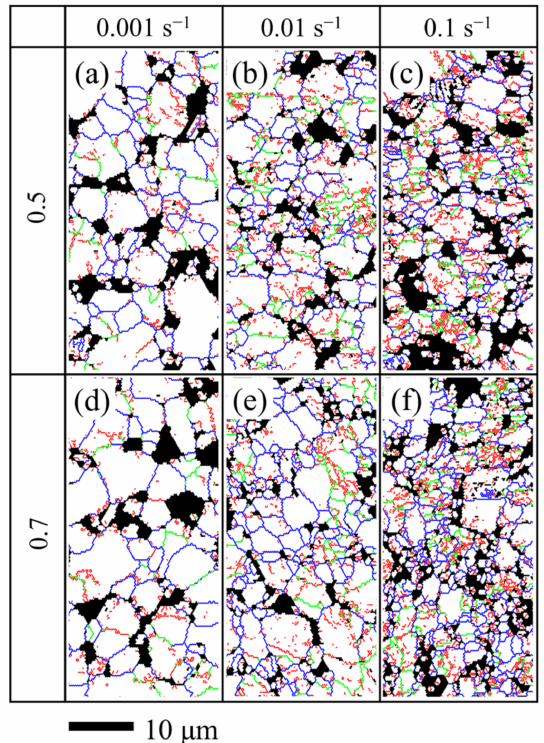
Figure 8. The distributions of the grain boundary at different strain and strain rates when deformed at 950 ◦ C: ( a – c ) strain 0.5; ( d – f ) strain 0.7; ( a , d ) strain rate 0.001 s − 1 ; ( b , e ) strain rate 0.01 s − 1 ; ( c , f ) strain rate 0.1 s − 1 (red lines represent LAGBs less than 5 ◦ , green lines represent MAGBs between 5 ◦ ~15 ◦ , blue lines represent HAGBs more than 15 ◦